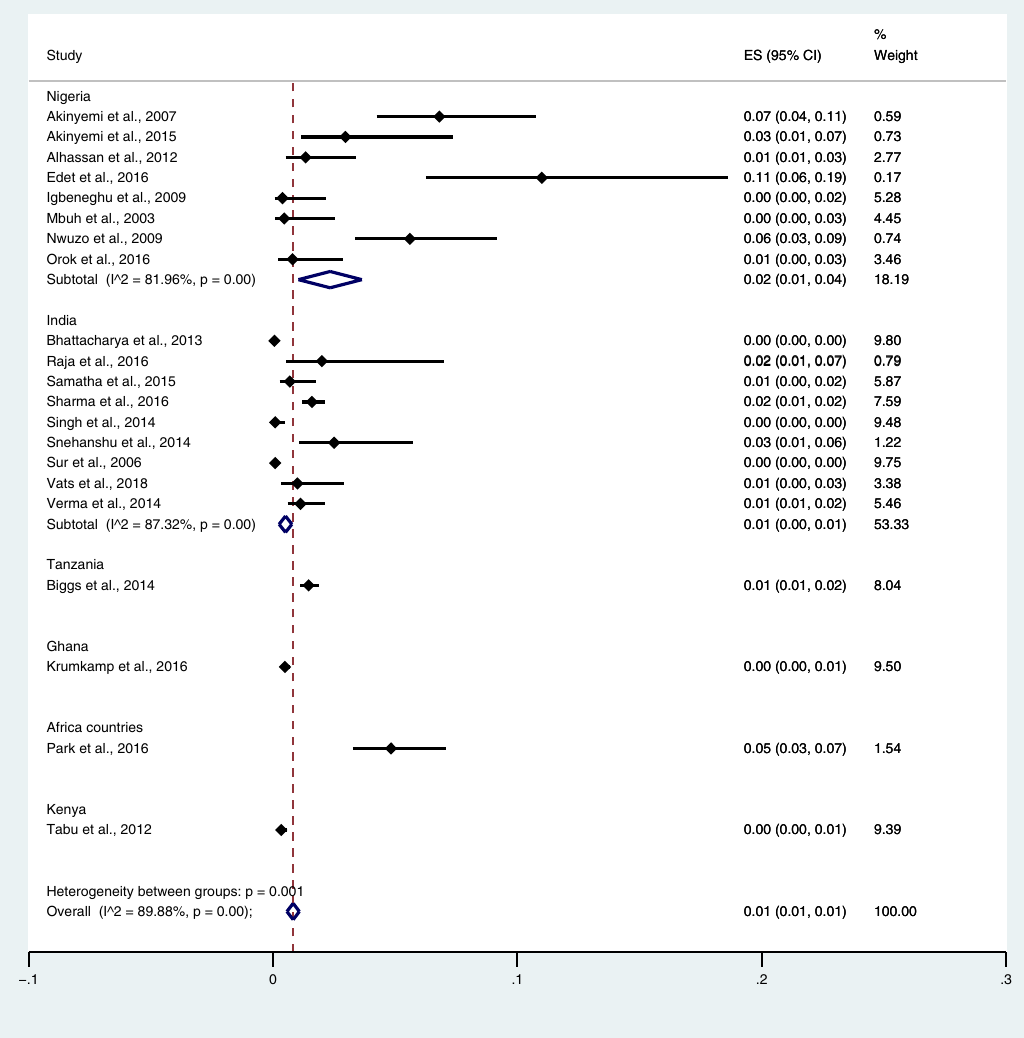
Heterogeneity between groups: p = 0.001 Overall (I^2 = 89.88%, p =